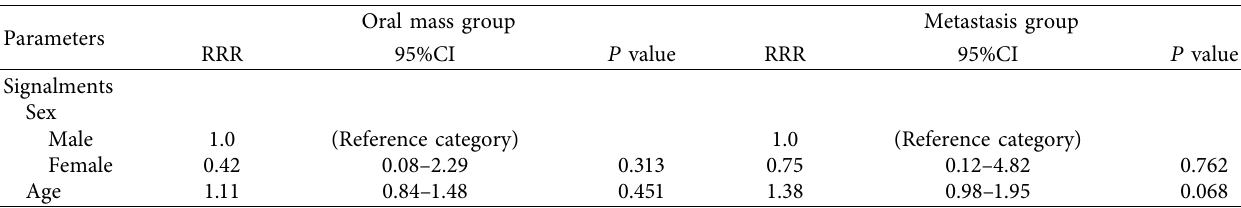
Table 2: Relative risk ratios (RRRs) of sex and age within the oral mass group and the metastasis group base outcome on the no oral mass group.